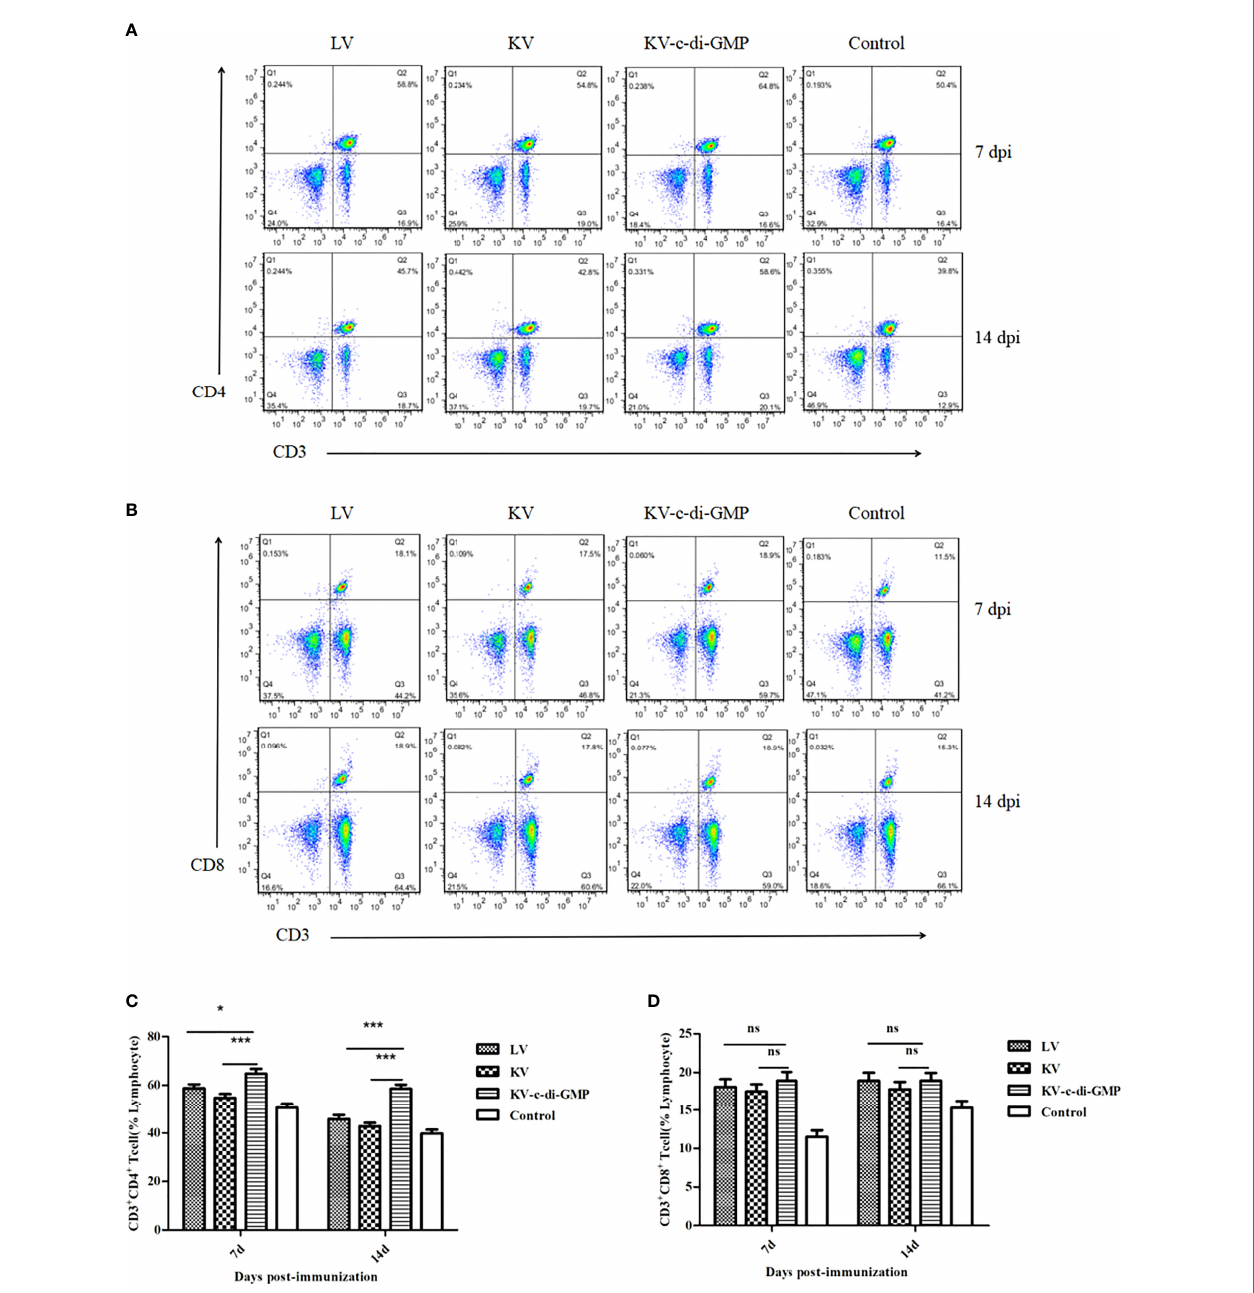
FIGURE 1 | Ratios of CD3 + CD4 + and CD3 + CD8 + lymphocyte subsets in the vaccine and control groups at 7 and 14 dpi of mice. FACS plots of (A) CD3 + CD4 + T cells and (B) CD3 + CD8 + T cells are representative of one of three independent experiments. Mean frequencies ± standard deviation of (C) CD3 + CD4 + T cells and (D) CD3 + CD8 + T cells. * P < 0.05; *** P < 0.001; ns, no signi fi cant